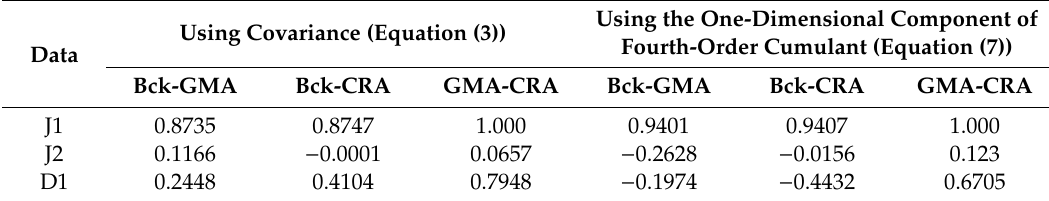
Table 4. Correlation between the three variables background (D1), GMA (Dcx) and CRA (N). Using the One-Dimensional Component Using Covariance (Equation (3)) Data